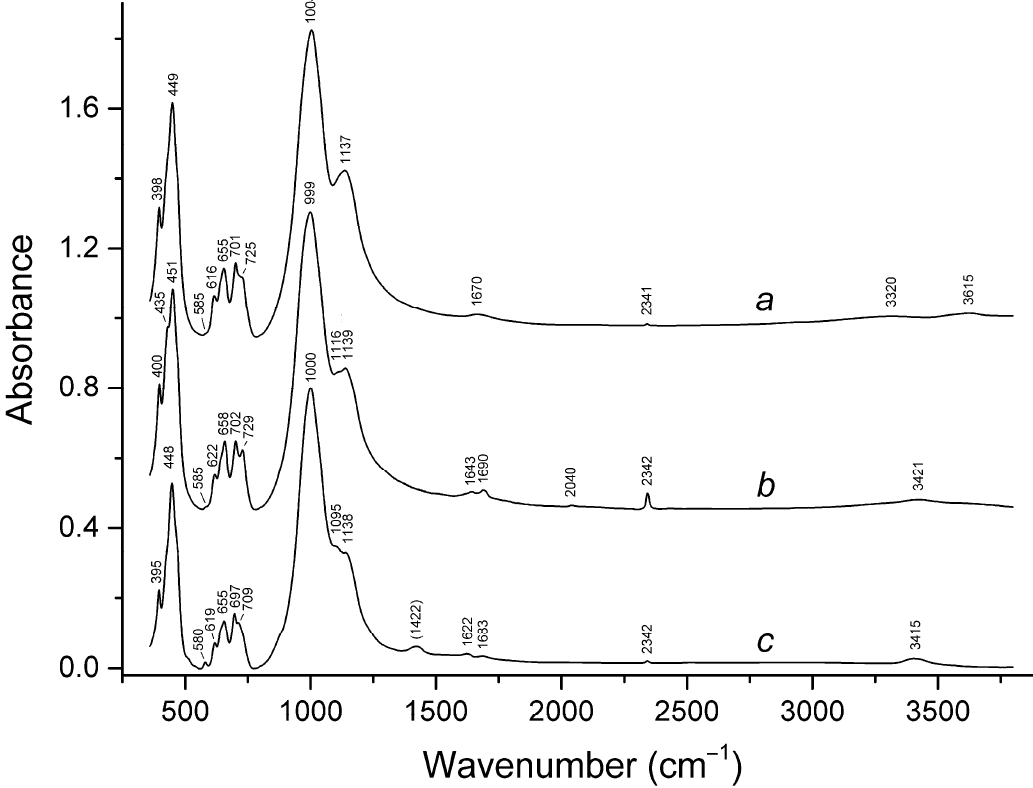
Figure 7. Infrared absorption spectra of the minerals belonging to the haüyne–lazurite solid-solution series: ( a ) PH, ( b ) KL, and ( c ) ZK.